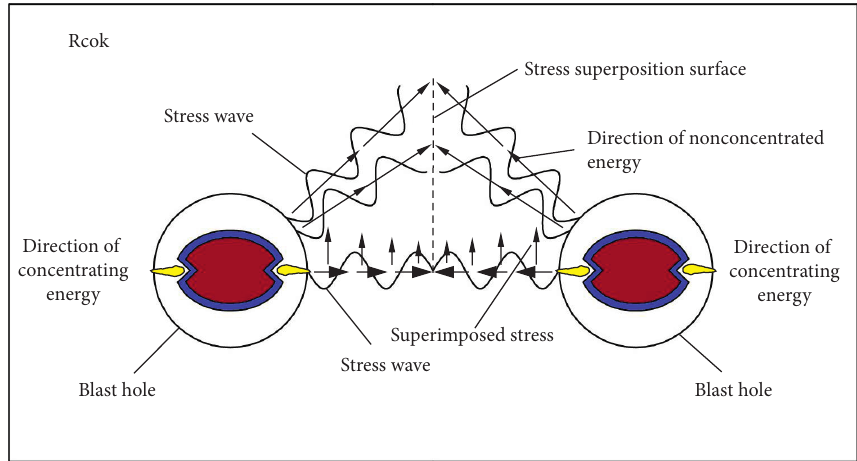
Figure 2: Mechanical model of continuous hole due to shaped charge blasting. Table 1: Explosive and parameters of equation of state [23].